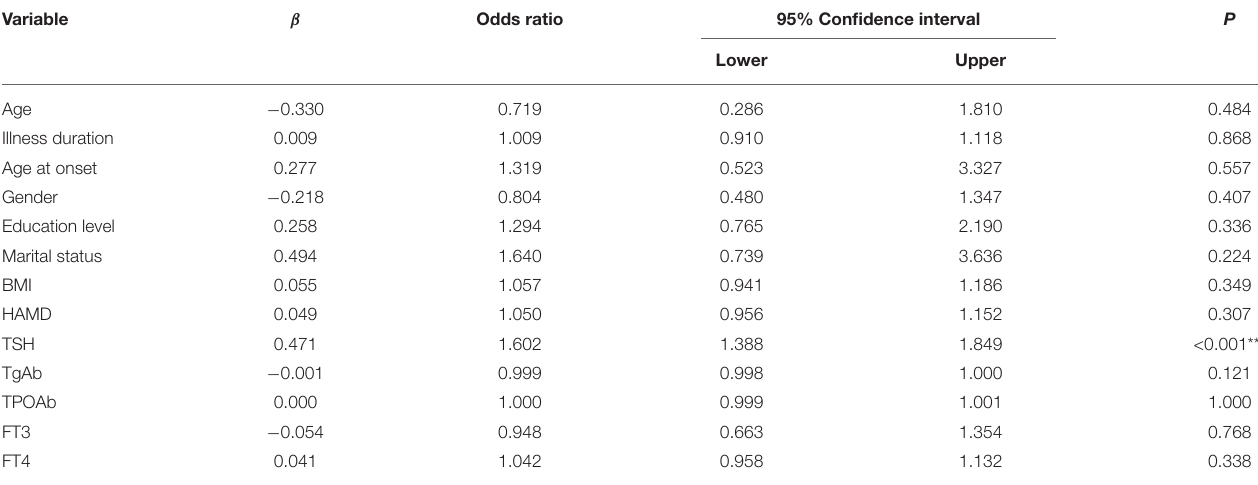
TABLE 2 | Multivariate binary logistic regression for factors associated with anxiety symptom in young FEDN MDD patients with SCH.